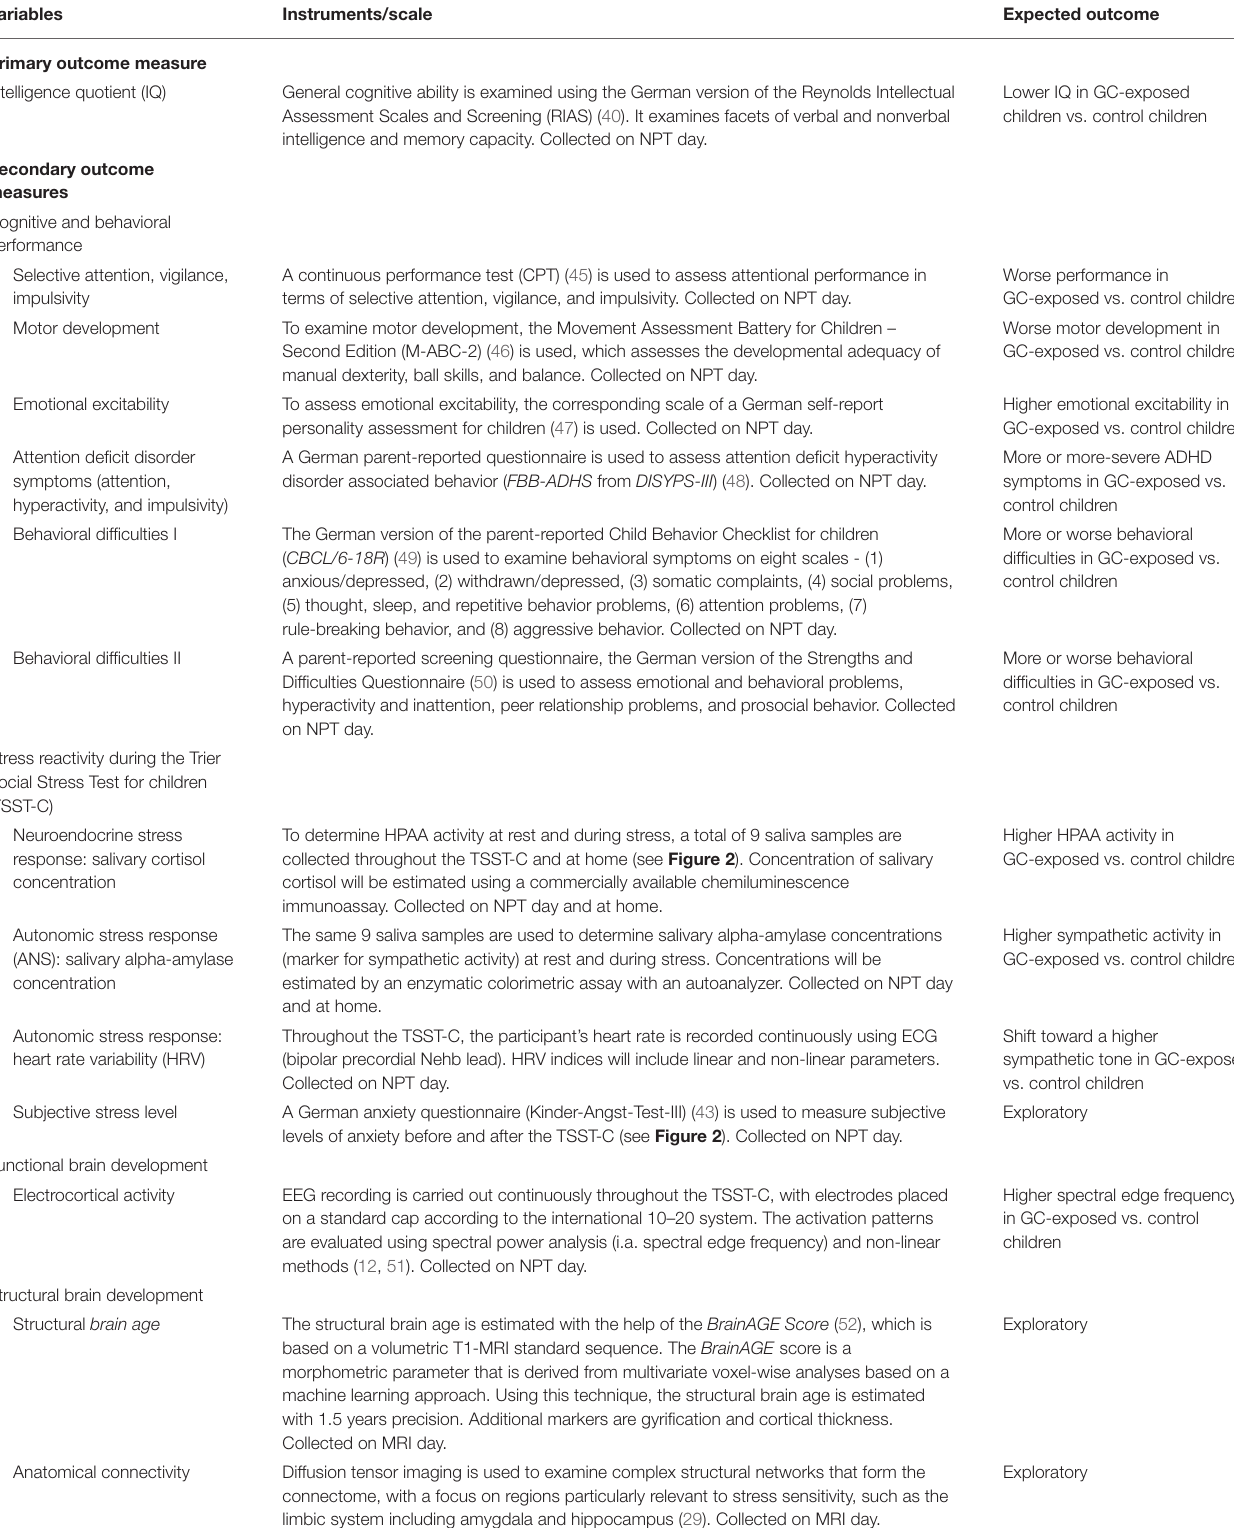
TABLE 2 | Primary and secondary outcome measures regarding the